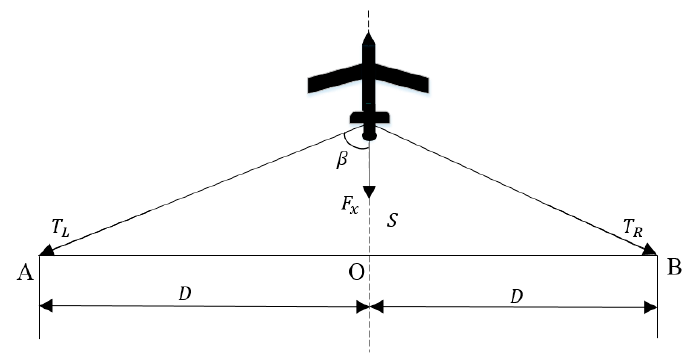
Figure 2. Schematic diagram of arresting force.